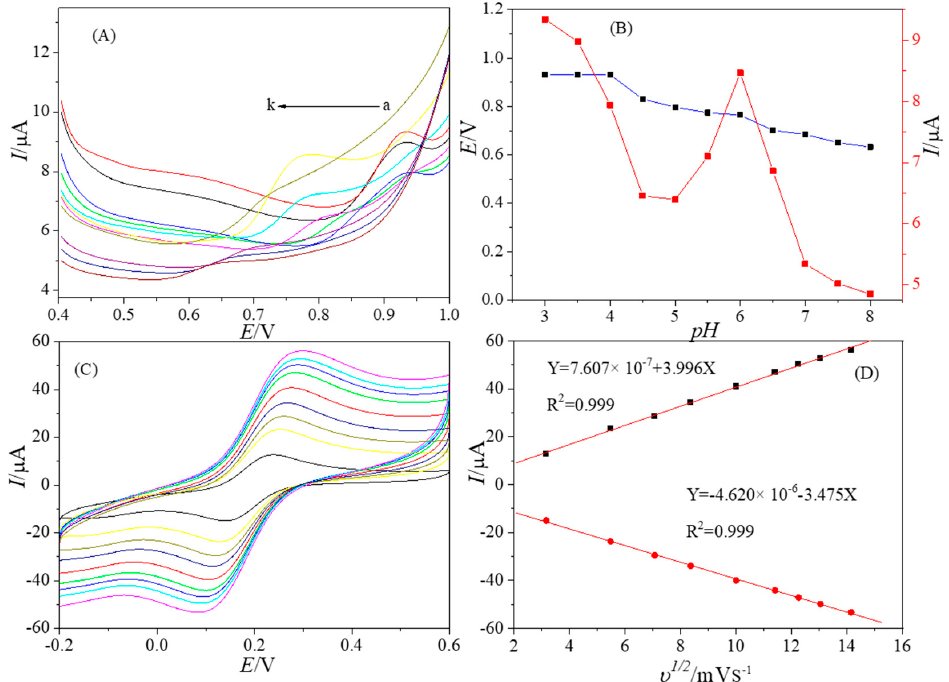
Figure 4. DPVs of PtNPs@GDY/GCE in 0.1 M PB with 0.5 μ M BPAF at different pH (from a to k: 3.0